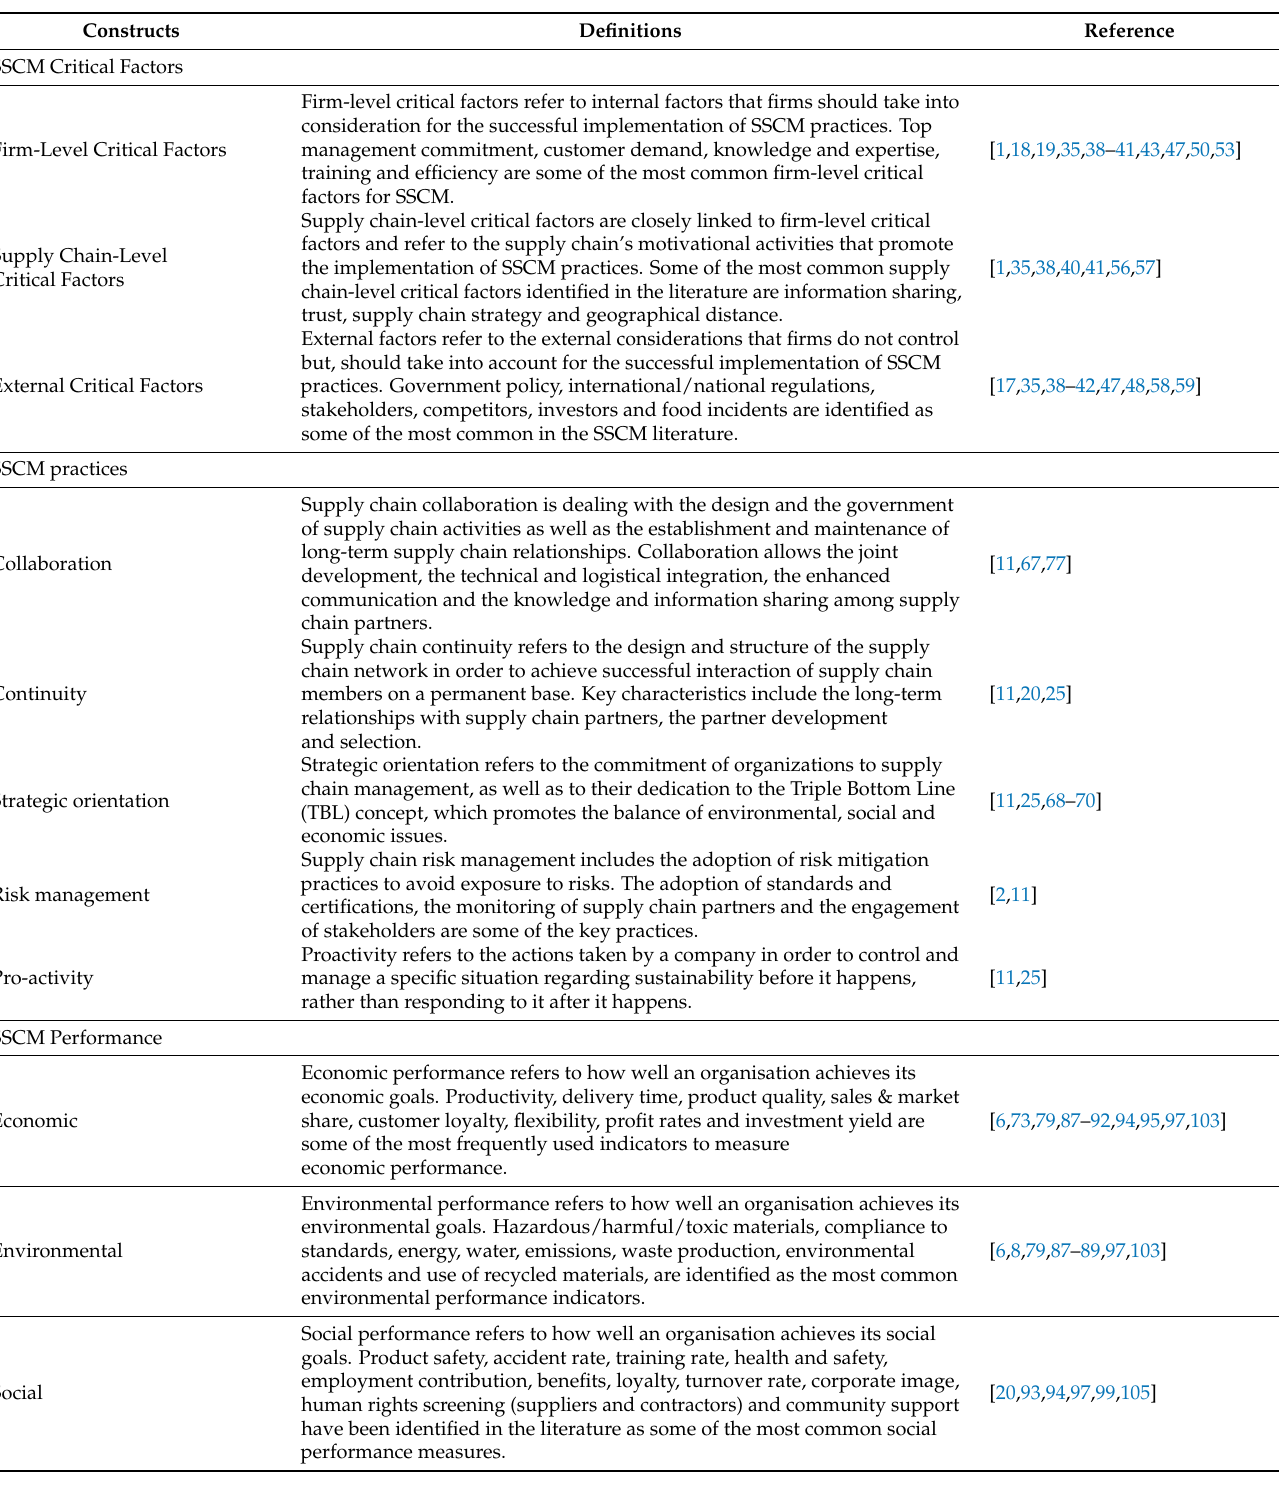
Table 2. Proposed SSCM constructs, along with their definitions and supporting